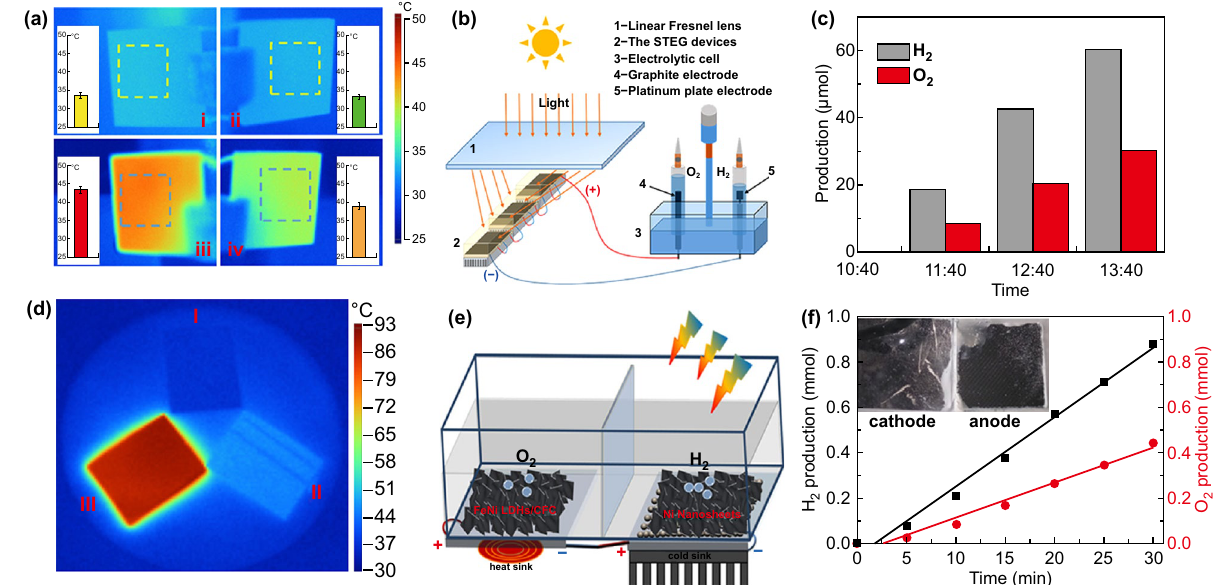
Fig. 11 a Temperature distributions under 1 sun irradiation of: (i) hot side and (ii) cold side of bare generator; (iii) hot side and (iv) cold side of CNP generator. Inserts: temperature statistics of the area in corresponding dotted box, b schematic of the overall water splitting system driven by 6 series-wound STEG devices, c production of H 2 and O 2 by the water splitting system at different time. Reproduced with permission from Ref. [156]. Copyright 2018 Elsevier Inc., d the infrared thermal images of Al 2 O 3 ceramic chip (I) and Al 2 O 3 ceramic chip with Ni film (II) and Ni nanosheets/Ni film (III), e illustration of electrolyzer-TE hybrid device, f H 2 /O 2 production versus time curve of electrolyzer-TE hybrid device with additional 0.7 V applied voltage. Reproduced with permission from Ref. [157]. Copyright 2019 Elsevier